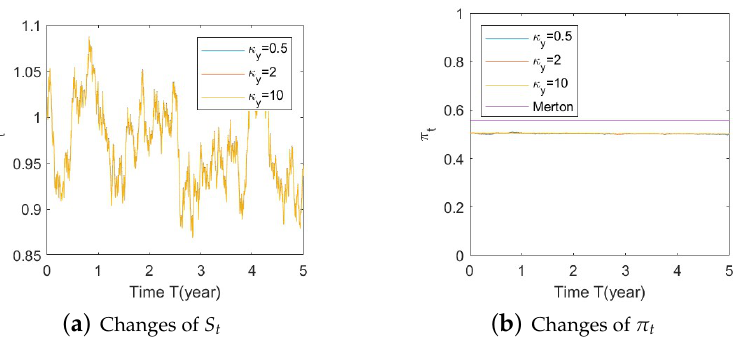
Figure A25. Illustrate the impact on ( a ) stock prices and ( b ) optimal stock allocations when varying the speed of reversion, κ y ( e . g ., κ y = 0.5,2,10 )